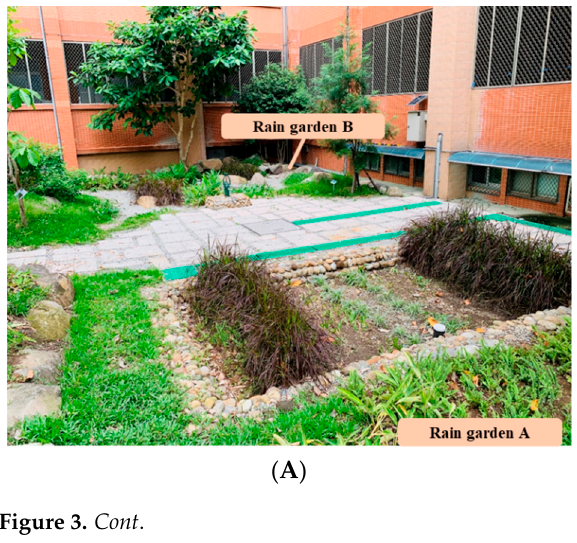
Figure 2. The studied permeable pavement site. ( A ) Site photo and ( B ) sketch of the site area.